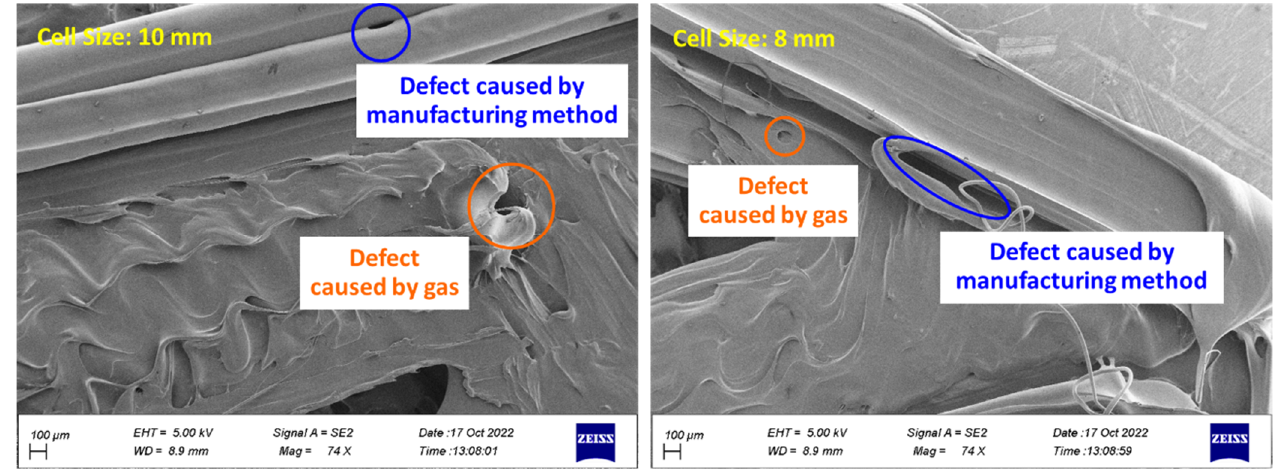
Figure 19. The defects fabricated on the surface of the sample during 3D printing.